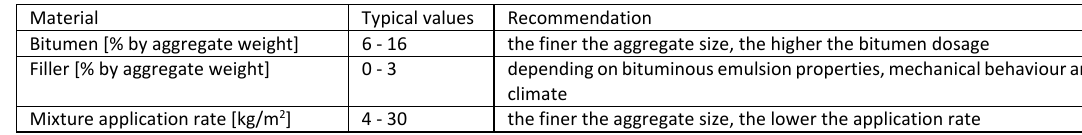
Table 2. Typical dosage ranges for BSS